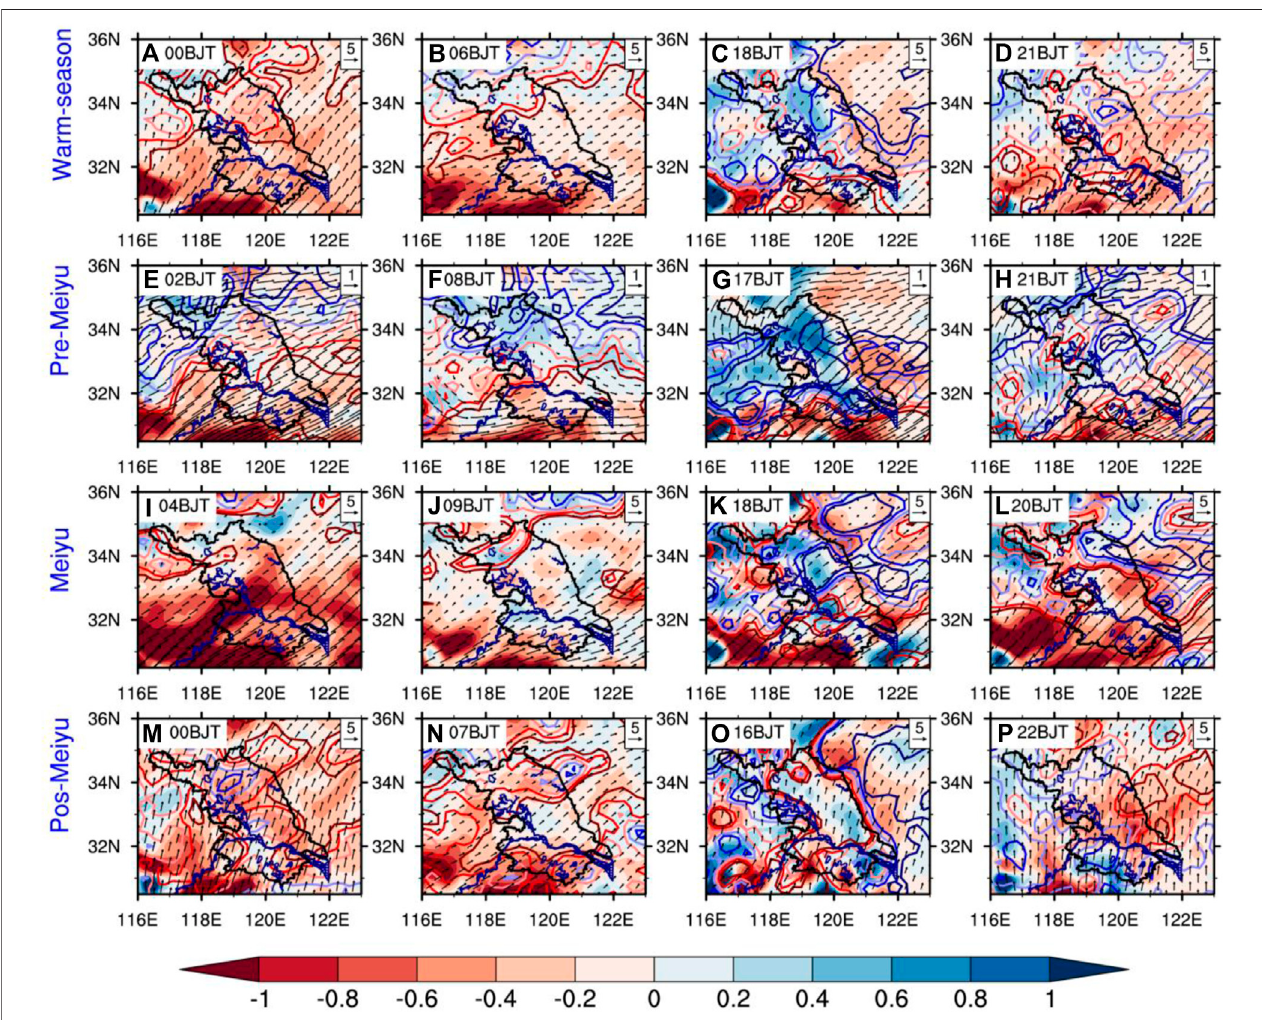
FIGURE 11 | The water vapor fl ux (arrows, units: 10 − 6 kg s − 1 m − 1 Pa − 1 ) and its divergence (shading, units: 10 − 9 kg s − 1 m − 2 Pa − 1 ) at 850 hPa and vertical velocity (contours, units: m · s − 1 , red means rising and blue means sinking, darker color means larger amplitude) at 500 hPa derived from the ERA5 data at different hour of a day during warm season (A-D) , Pre-Meiyu (E-H) , Meiyu (G-I) and Post-Meiyu (M-P) periods over 2013 – 2017.